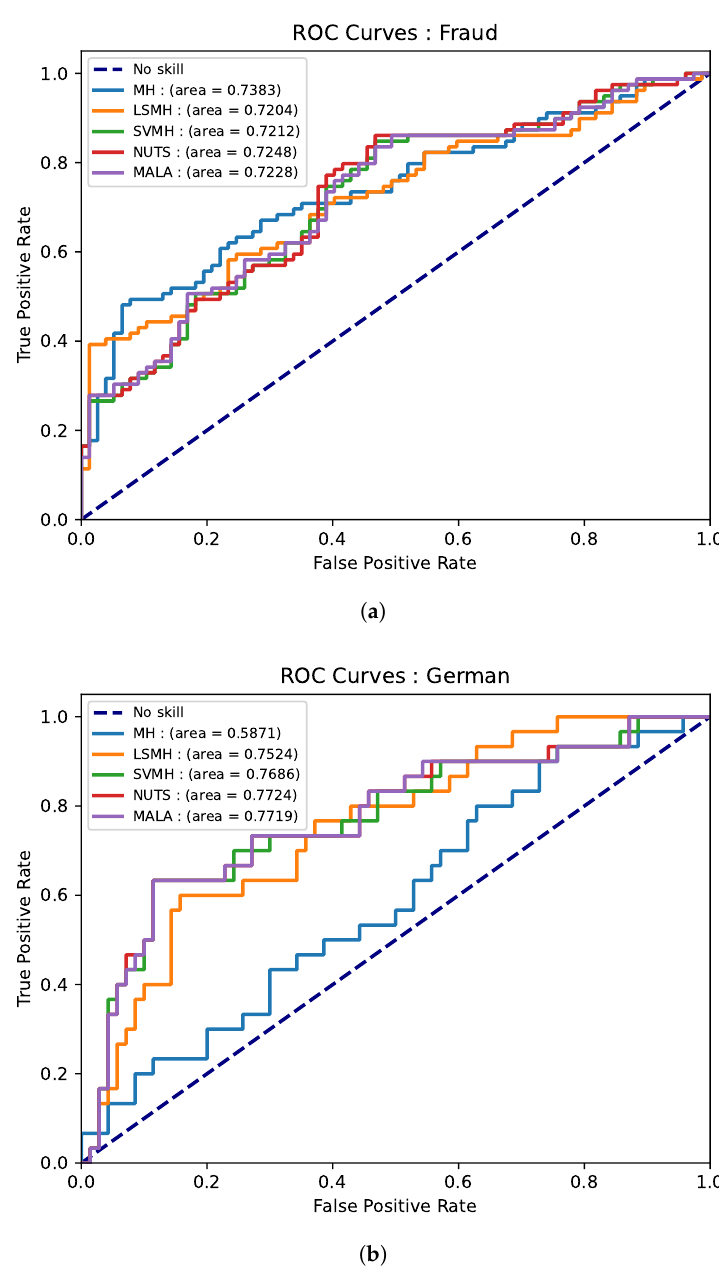
Figure 5. Predictive performance for all the sampling methods on the real world classification datasets. The results were averaged over thirty runs of each algorithm. ( a ) ROC curves for the Fraud dataset and ( b ) ROC curves for German